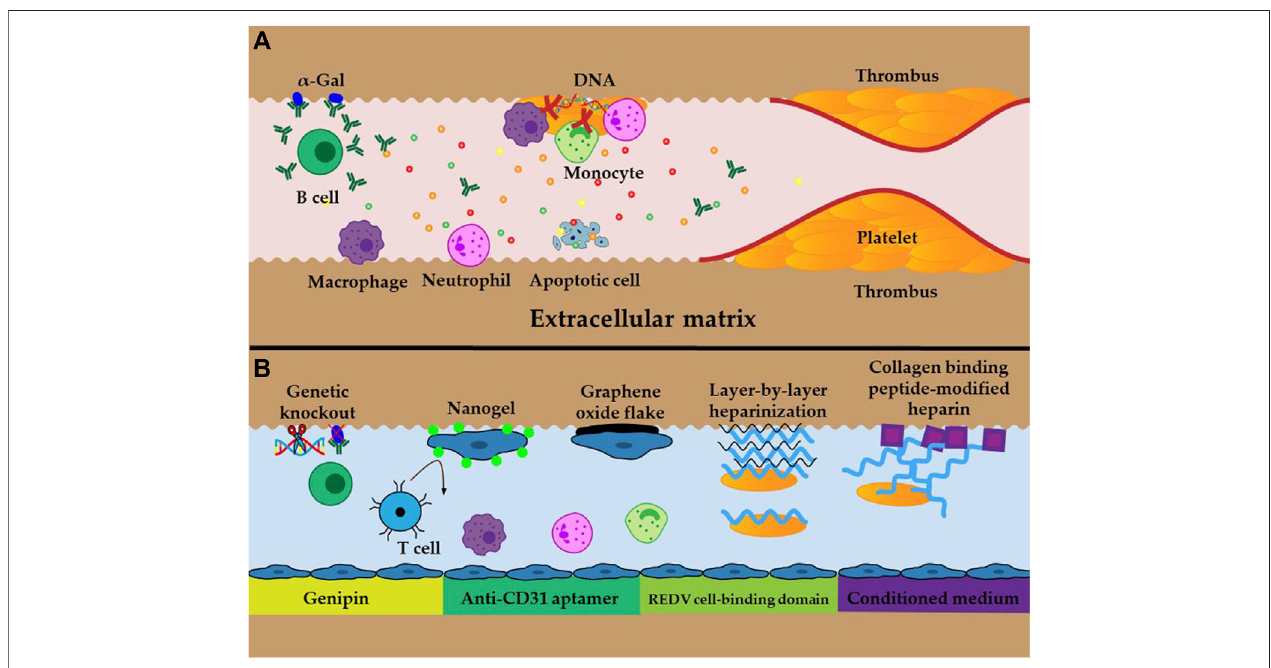
FIGURE 3 | Schematic illustration of obstacles and approaches (A) In fl ammatory response, oxidative stress, cell apoptosis, and thrombosis caused by residual DNA and Gal epitopes and exposed ECM (B) Examples of cross-linking and techniques to improve immunogenicity and thrombosis.